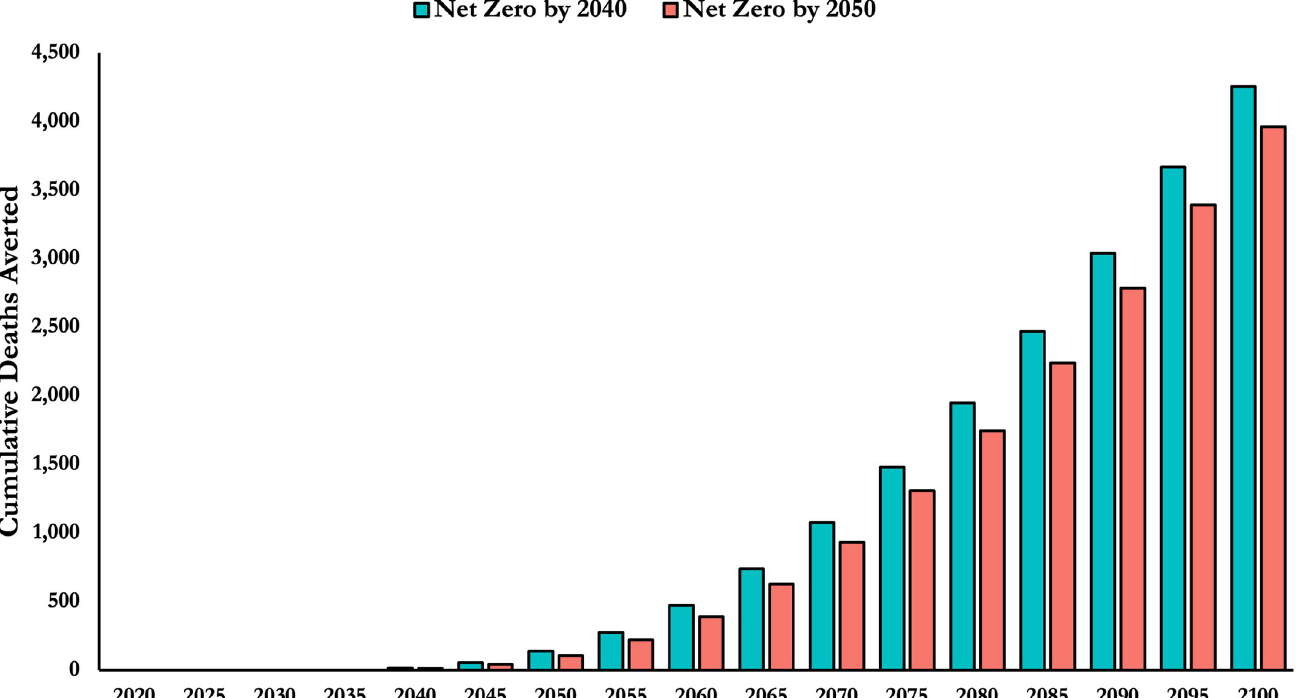
Fig 2. Cumulative temperature-related deaths averted from earlier decarbonisation of the health sector. The majority of lives are saved in the later part of the century.